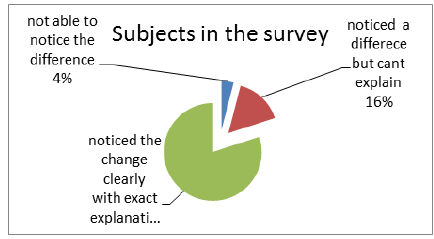
Figure 11. Subjective Testing